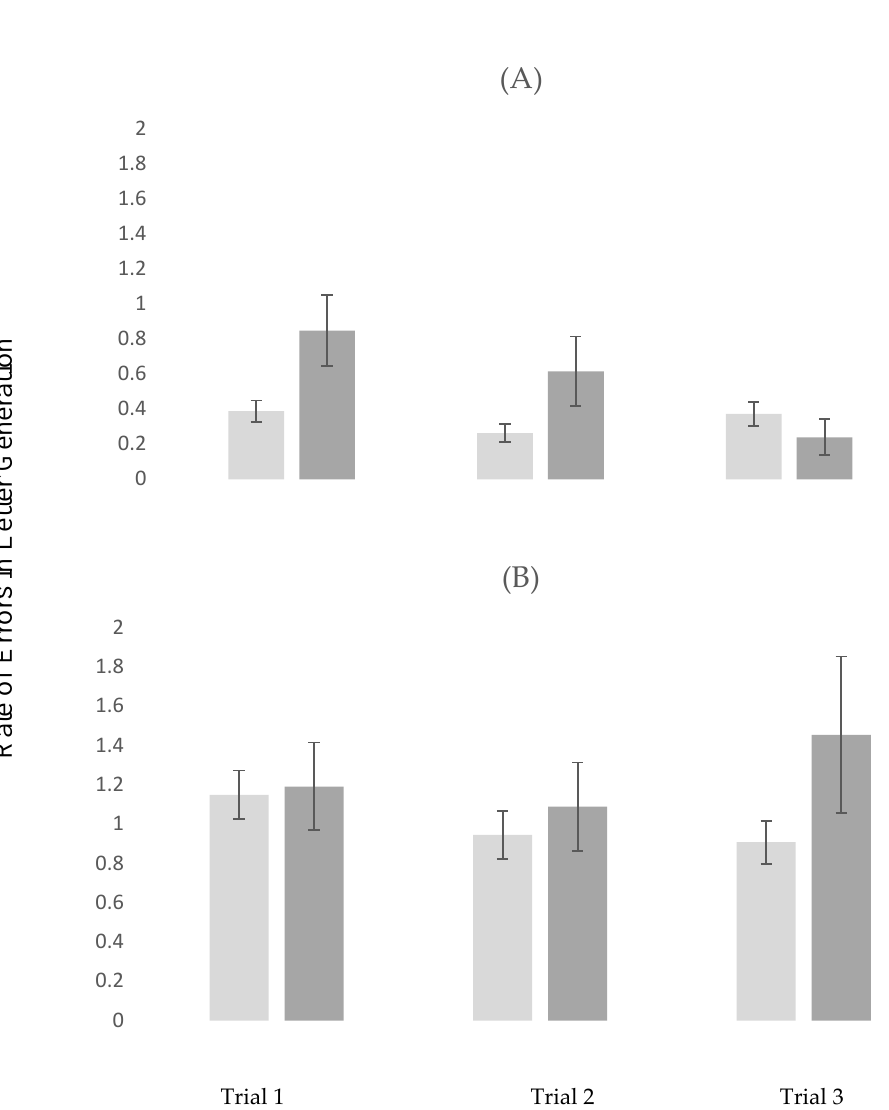
Figure 4. Changes in errors in letter generation across repeated trials stratified by task conditions